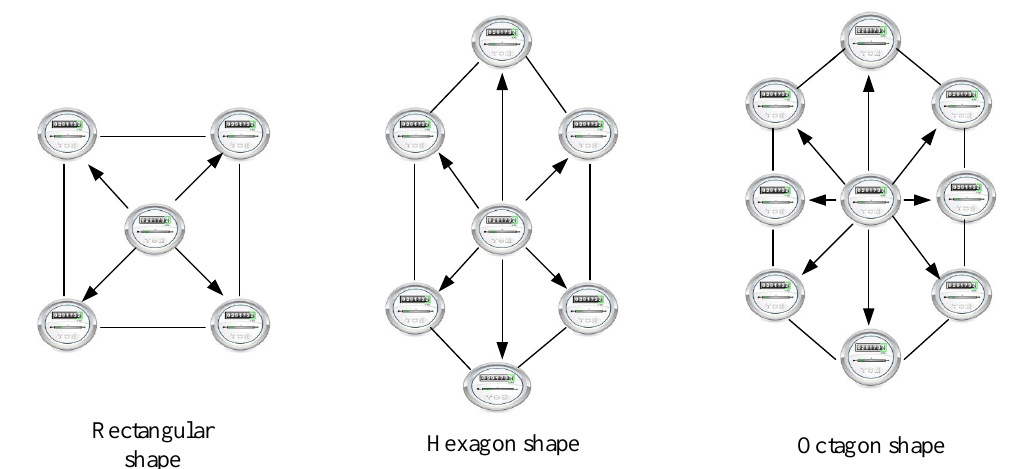
Figure 5. Different shapes of the area of interest (AOI).